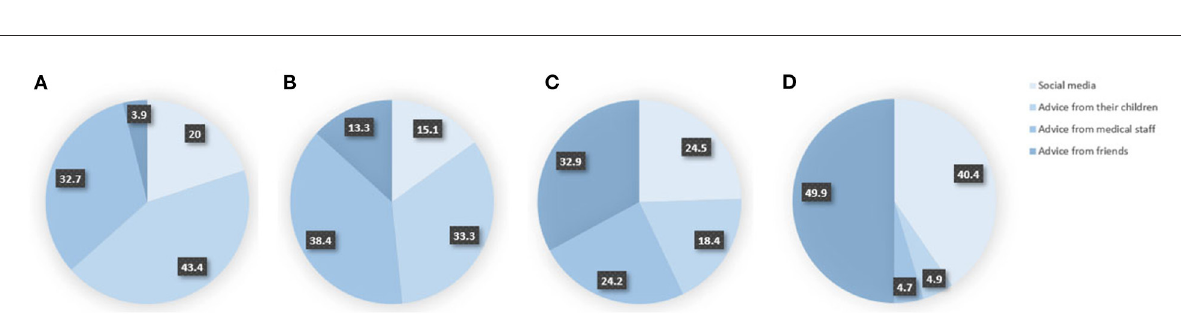
specific subgroups of several existing studies (20, 39, 41). A large-